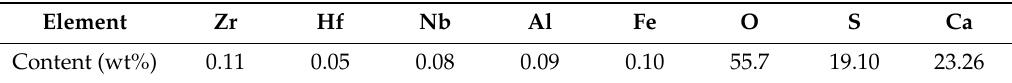
Table 4. Chemical composition of calcium sulfate precipitate.